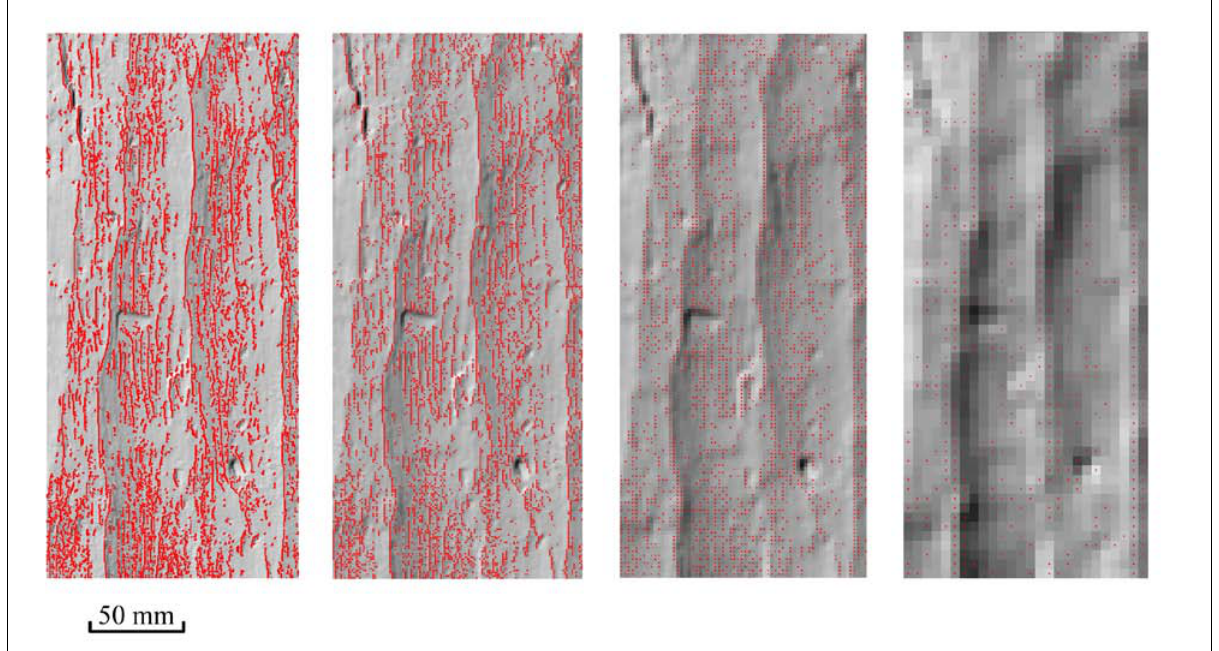
Figure 6. The comparison of different raster calculations – interpolations with various raster sizes (from left to right: 0.5 mm, 1 mm, 2 mm, 5 mm) and their hillshade models with the exported XYZ coordinates (red